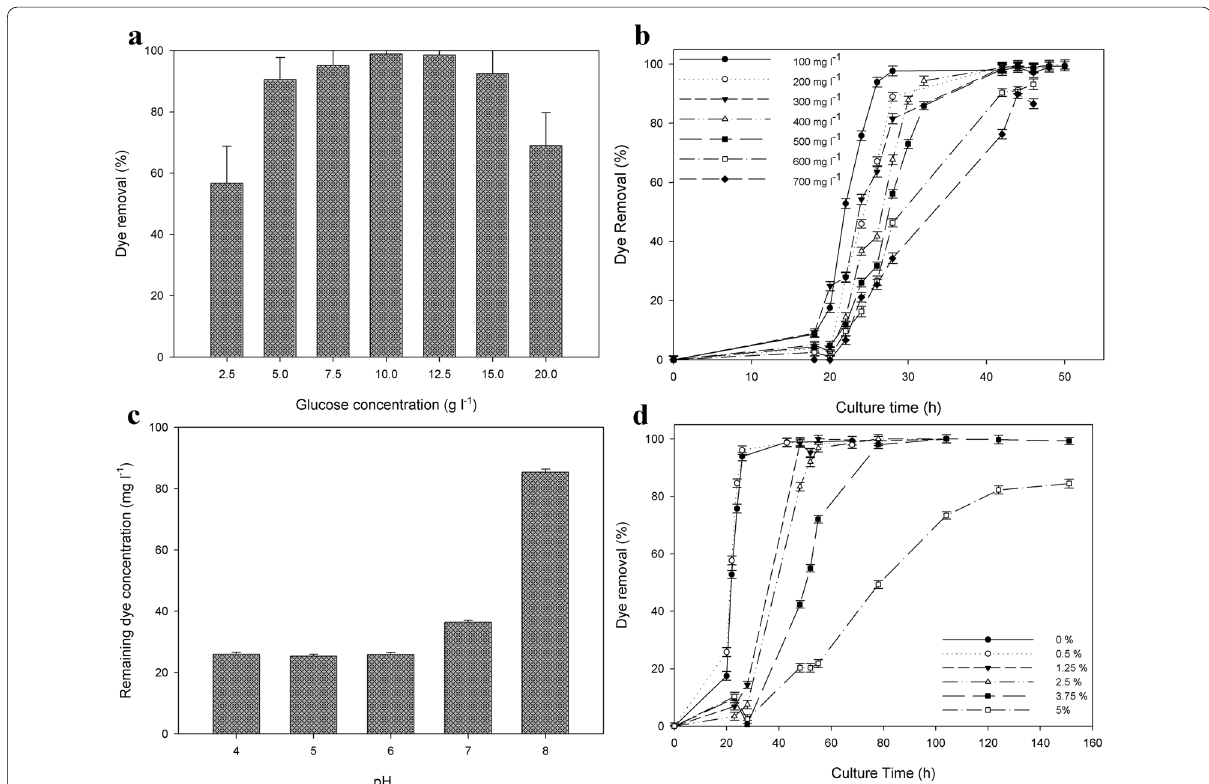
Fig. 4 Dye removal by Leucosporidium muscorum F20A as a function of different cultivation parameters. Panel a: effect of medium-glucose concentration. In the figure, the percent dye removal after 26 h of cultivation is plotted on the ordinate as a function of the initial medium-glucose concentration in g L –1 on the abscissa . Panel b: effect of Reactive Black-5 concentration. In the figure, the percent dye removal at different dye concentrations is plotted on the ordinate as a function of culture time in h on the abscissa . Panel c Effect of initial pH. In the figure, the percent dye remaining after cultivation for 26 h is plotted on the ordinate as a function of the initial medium pH on the abscissa . Panel d Effect of NaCl concentration. In the figure, the percent dye removal is plotted on the ordinate as a function of culture time in h on the abscissa for different NaCl concentrations, expressed as a percent (w/v). Data are presented as the mean and standard deviation (error